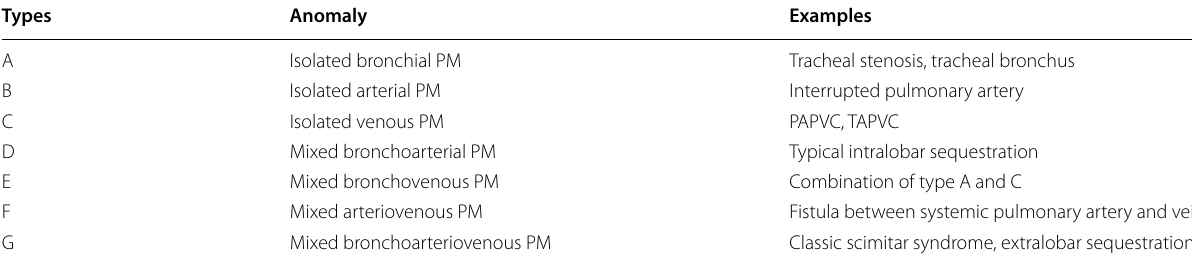
Table 2 Classification of bronchopulmonary malinosculation by Lee et